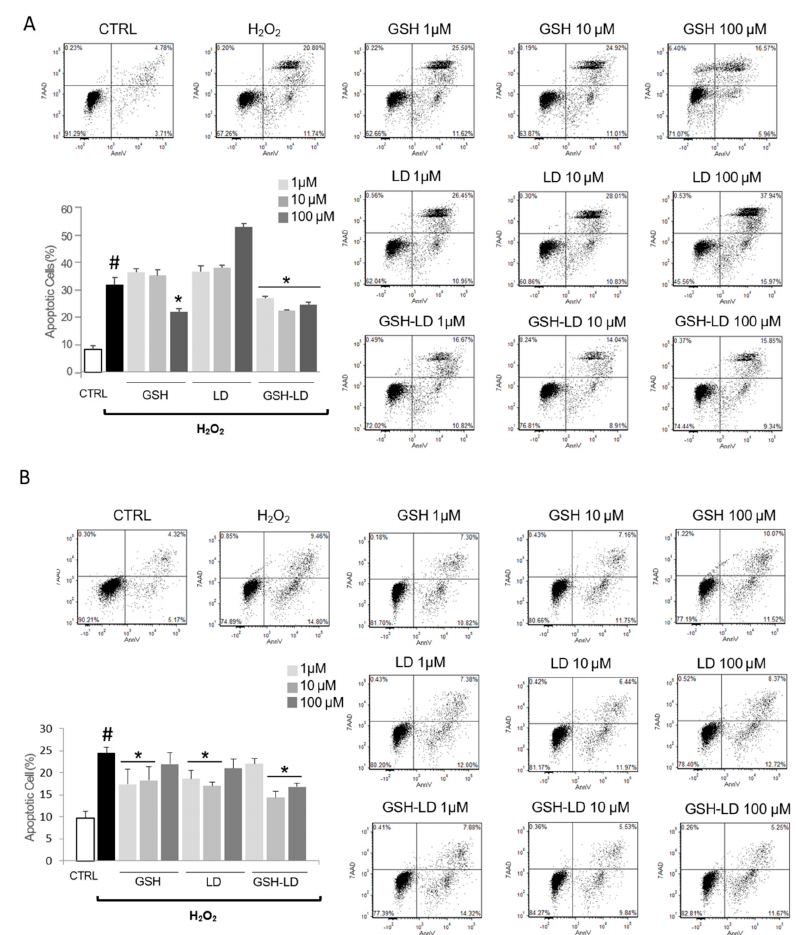
Figure 3. Effects of compounds on H 2 O 2 -induced apoptosis in a monocytic cell line. Effects of GSH, LD and GSH-LD on H 2 O 2 -induced apoptosis of U U937 ( A ) and D U937 ( B ). Cells were treated with different concentrations of compounds (1, 10 and 100 μ M) for 1 h, and then exposed to H 2 O 2 (500 μ M) for 4 h. An Annexin V assay was used for apoptosis detection. Data is presented as the mean ± standard deviation ( n = 6). # p < 0.01, vs. control (CTRL); * p < 0.01 vs. H 2 O 2 -treated